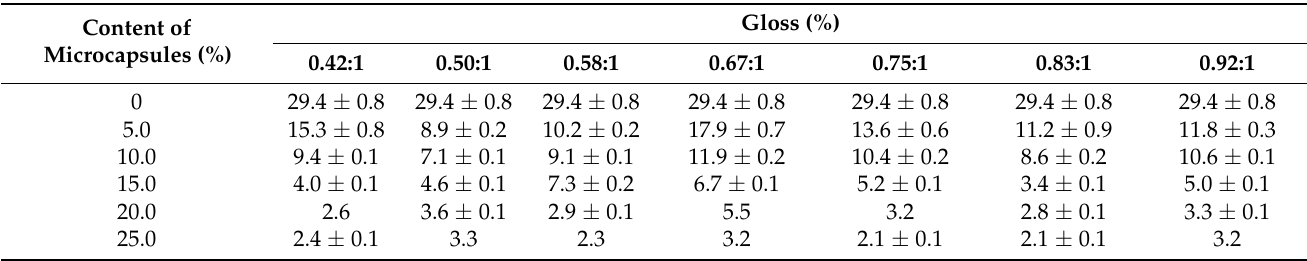
Table 2. Variation of gloss of water-based topcoat paint film.